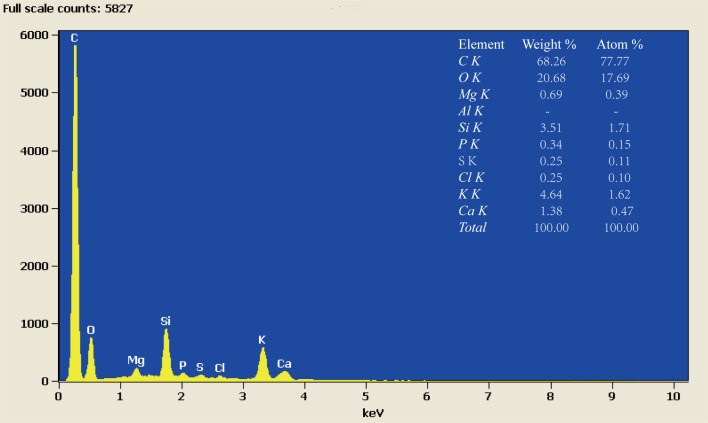
Energy spectrum analysis for biochar surface produced at 450°C.